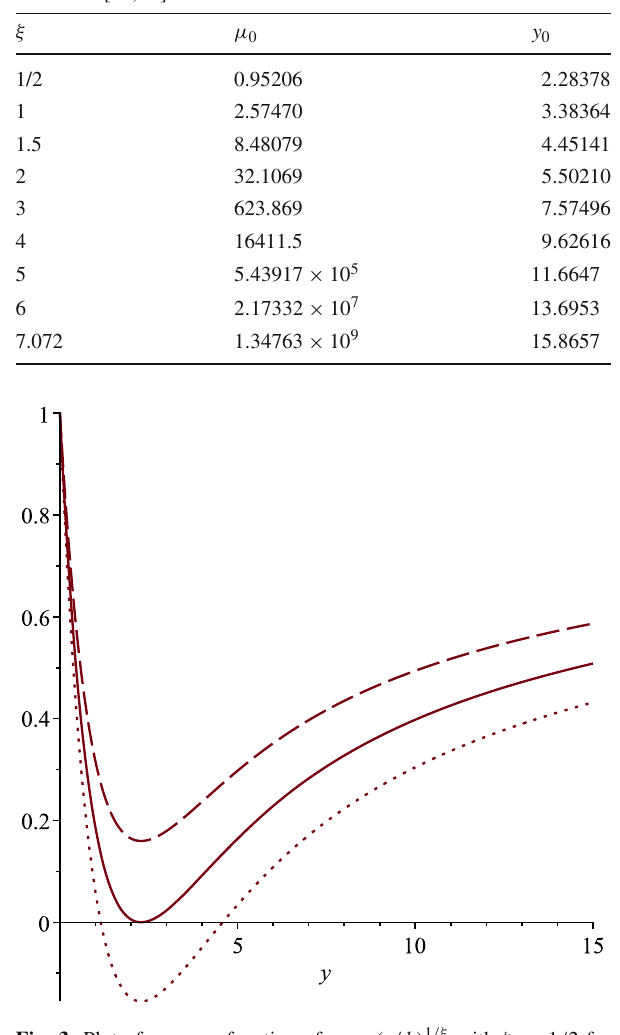
Fig. 3 Plot of g 00 as a function of y = ( r / h ) 1 /ξ with ξ = 1 / 2 for different values of μ . The intersections on the horizontal axis represent the radii of the event horizons expressed in the variable y . If μ = μ = 0 . 95206, there is one degenerate horizon at y 0 line). For μ = 1 . 1 > μ 0 (dot line), there are two horizons and in the case μ = 0 . 8 < μ 0 (dash line), there is no horizon. The latter case